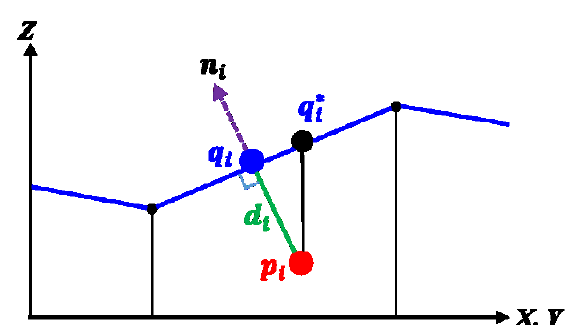
Figure 1. Distance measure of the point-to-surface matching between the GCPs ( 𝒑 𝑖 ) and surface Z(X,Y) of a